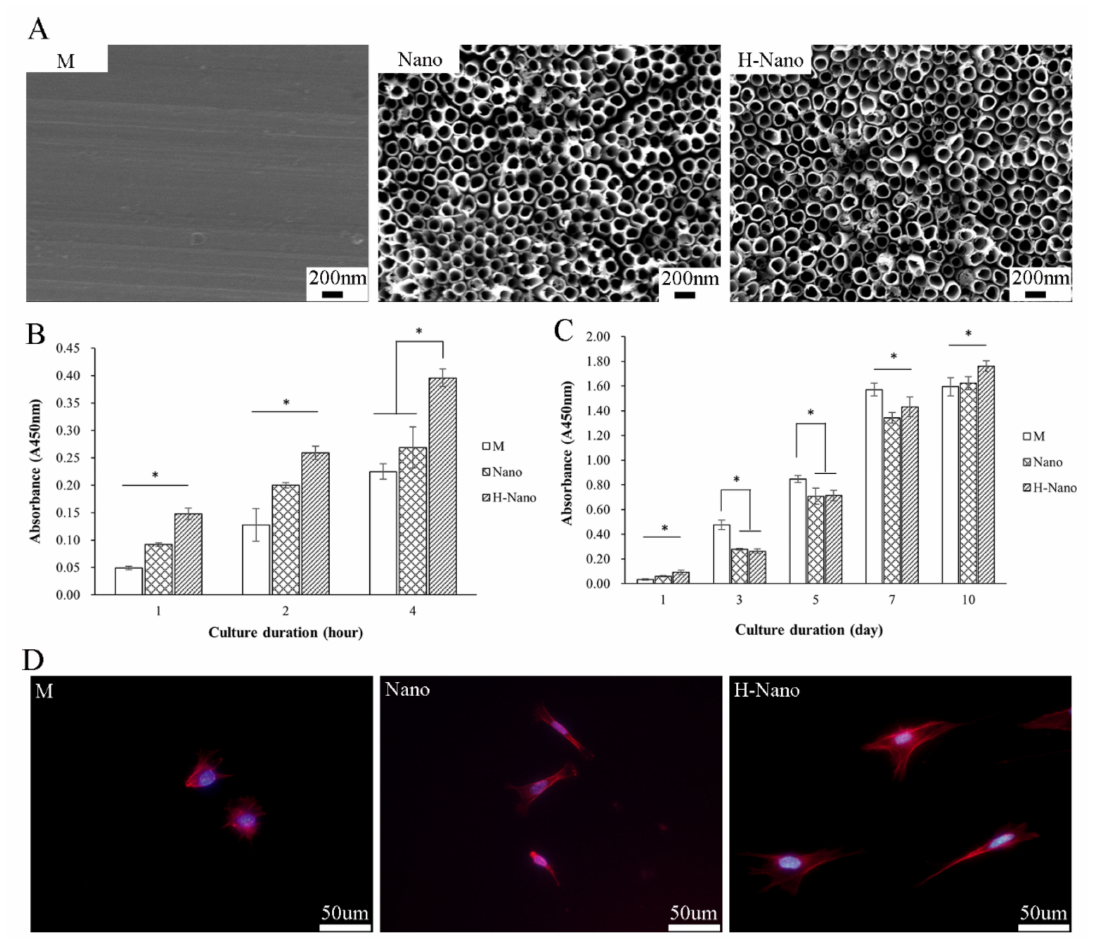
Figure 2. ( A ) SEM images of the M, Nano, and H-Nano surfaces at magnification of × 30,000. ( B ) BMSC adhesion on the surfaces of the M, Nano, and H-Nano detected by cell counting kit-8 assay after culturing for 1, 2, and 4 h. ( C ) Cell proliferation activity on specimens after 1, 3, 5, 7, and 10 days of incubation. ( D ) Immunofluorescent images of BMSCs adhered to the M, Nano, and H-Nano surfaces after culturing for 24 h. Cellular F-actin was labeled by Alexa Fluor™ 555 Phalloidin (red) and nuclei were stained with DAPI (blue). * p <